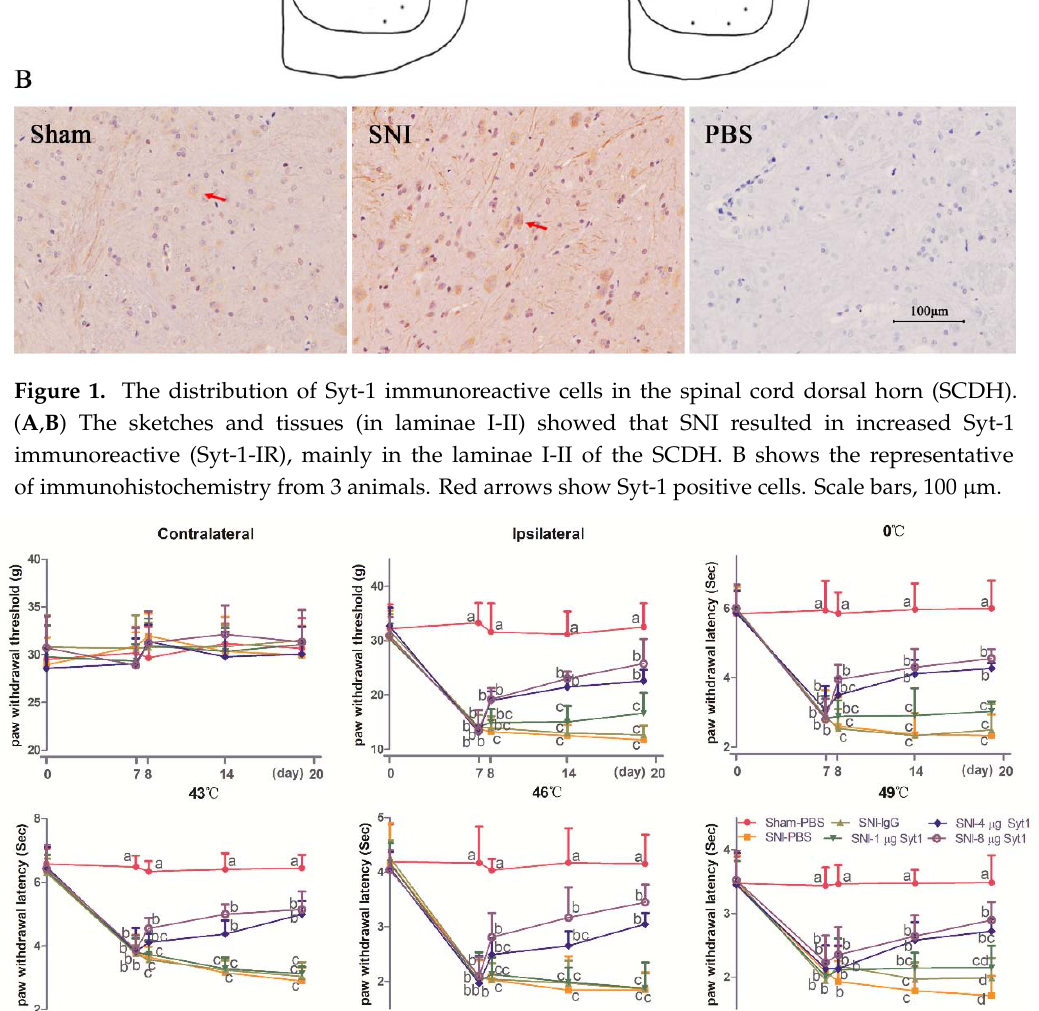
Figure 2. The e ff ect of Syt-1 antibody on paw withdrawal thresholds (PWTs) and paw withdrawal Figure 2. The effect of Syt ‐ 1 antibody on paw withdrawal thresholds (PWTs) and paw withdrawal latencies (PWLs) (Mean ± SD, n = 6). Rats in SNI + di ff erent doses of Syt-1 antibody were intrathecally latencies (PWLs) (Mean ± SD, n = 6). Rats in SNI+ different doses of Syt ‐ 1 antibody were intrathecally injected with 1, 4, or 8 µ g antibody at day 8 and once every two days. SNI induced a decrease in PWLs injected with 1, 4, or 8 μ g antibody at day 8 and once every two days. SNI induced a decrease in PWLs (0, 43, 46, and 49 ◦ C) and ipsilateral PWTs at day 7 to 20. Syt-1 antibody treatment caused increased (0, 43, 46, and 49 °C) and ipsilateral PWTs at day 7 to 20. Syt ‐ 1 antibody treatment caused increased PWLs (0, 43, 46, and 49 ◦ C) and ipsilateral PWTs in a dose-dependent manner at day 8 to 20. Values with PWLs (0, 43, 46, and 49 °C) and ipsilateral PWTs in a dose ‐ dependent manner at day 8 to 20. Values di ff erent letters (a, b and c) at the same day show di ff erent ( p < 0.05); two-way ANOVA followed by with different letters (a, b and c) at the same day show different ( p < 0.05); two ‐ way ANOVA followed Bonferroni by Bonferroni test.